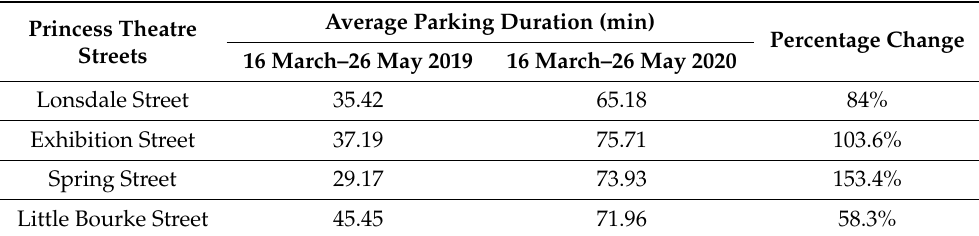
Table 6. Street level comparisons of the average parking duration change, in minutes, between